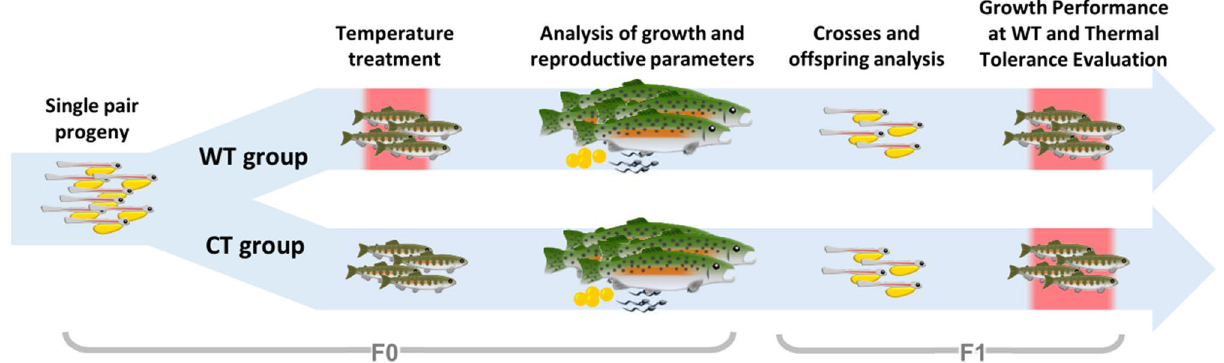
Figure 1. Overview representation of the experimental design. Rainbow trout juveniles obtained from a single pair cross were divided in two groups. At six-months, one group was exposed to warm temperature (WT) for three months in a local fish farm (Pindamonhangaba) while control group was maintained at Salmonid Experimental Station (Campos do Jordão). After this period, the treated group returned to control temperature until reaching sexual maturity for the analysis of growth and reproductive parameters. Finally, survival and growth performance of respective progeny at WT and upper thermal tolerance were